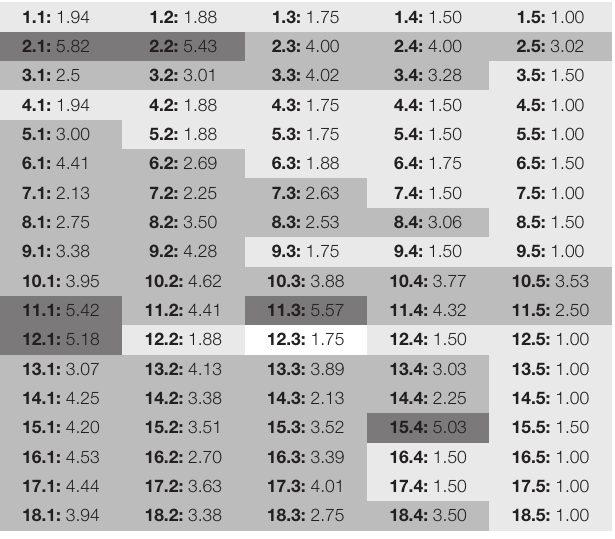
TABLE 1 | The dimensions and their quantitative influences. Dimensions Influence of other dimensions